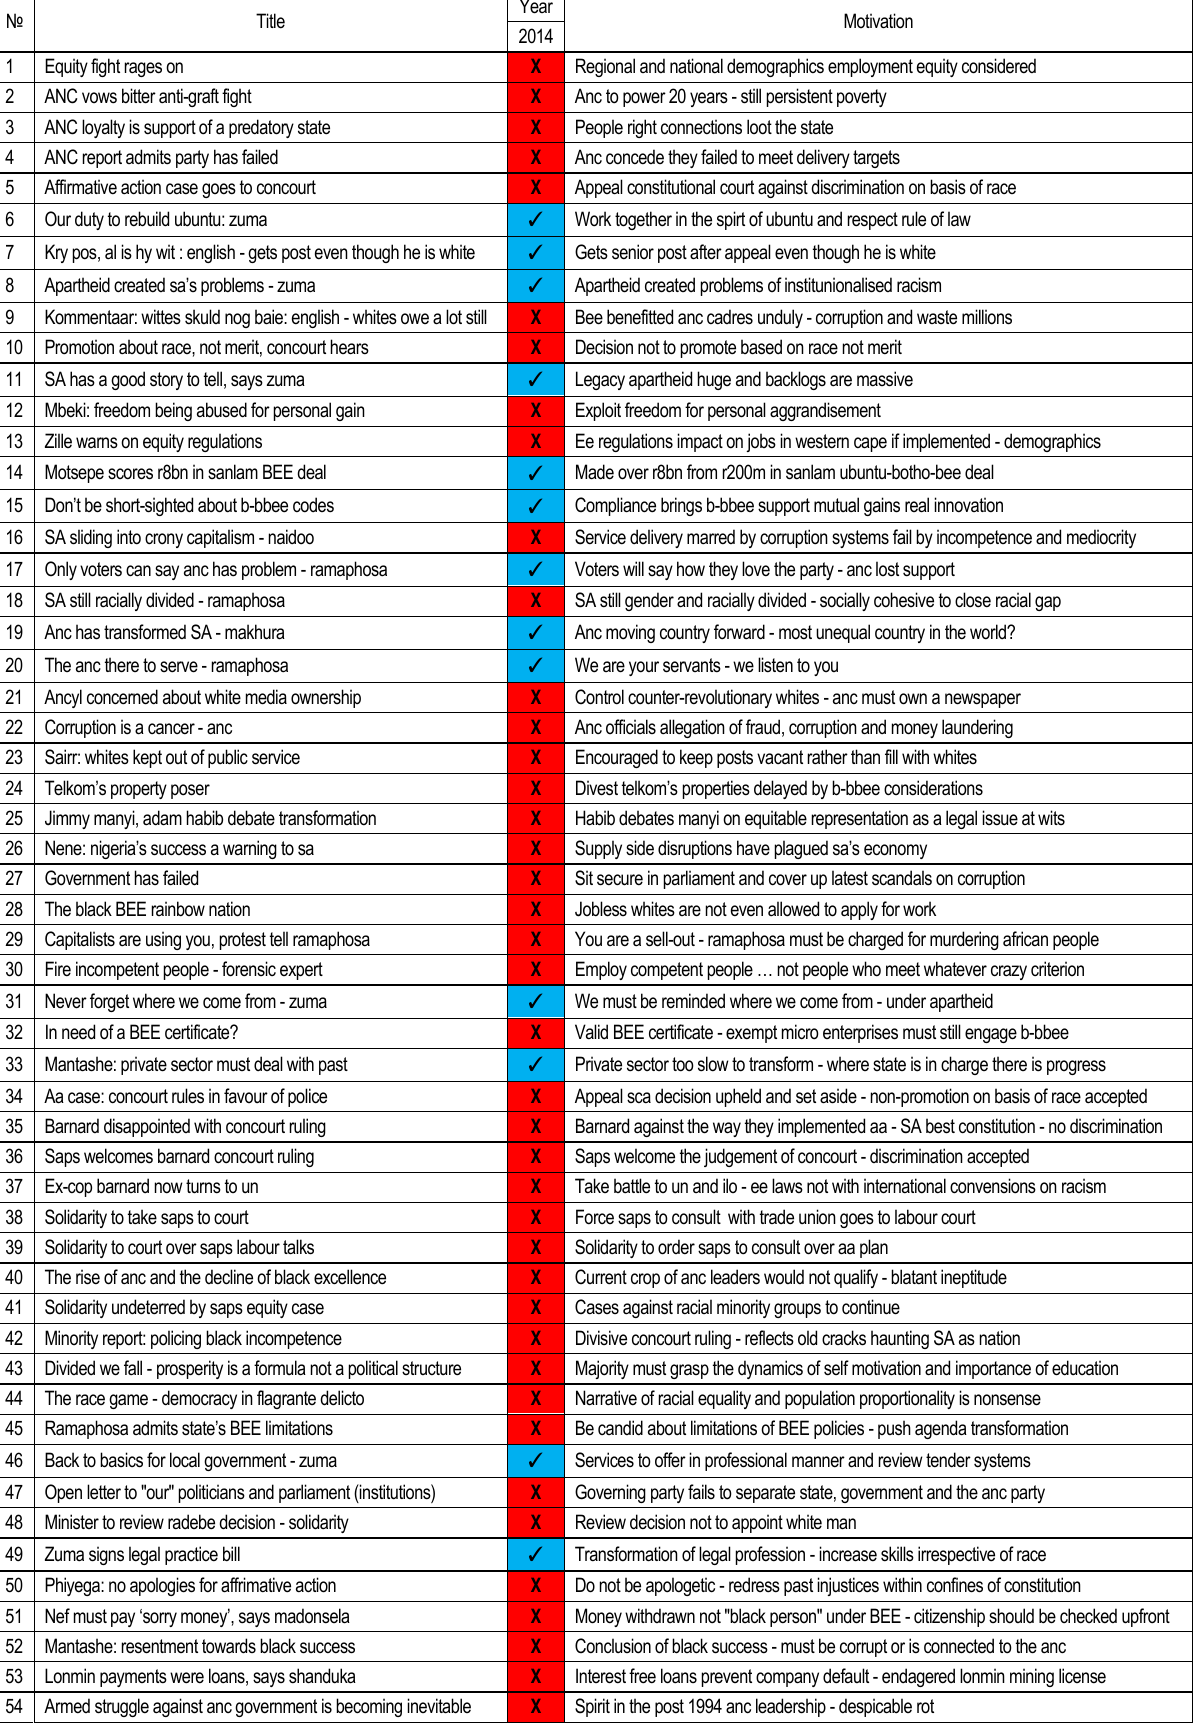
Table 1A. Impact of BEE (January-December